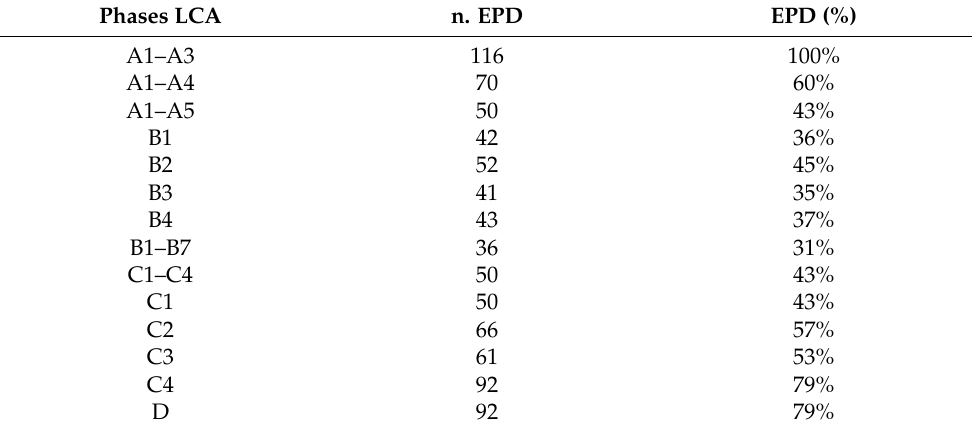
Table 5. Number of EPDs and their percentage value with respect to the entire sample of data in relation to each LCA